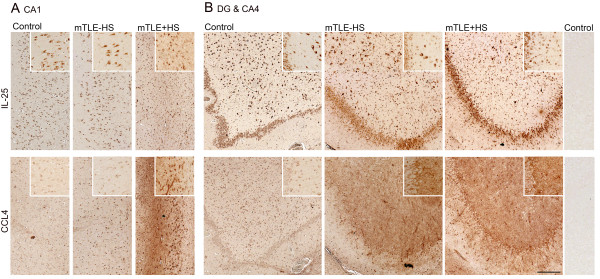
Hippocampal expression patterns of IL-25 and CCL4 in Control, mTLE-HS and mTLE + HS patients. Photomicrographs showing typical examples of Il-25 and CCL4 staining in the hippocampal CA1 region (A) and the DG/CA4 region (B). IL-25 immunoreactivity (IR) is evident in cells with neuronal morphology in all three patient groups (A, B); note the increased IL-25 staining in the mTLE + HS hippocampus in small cells. CCL4 IR is low in controls (A, B). Increased CCL4 IR is detected in both mTLE patient groups in the DG-CA4 area (B) and in the CA1 area of mTLE + HS patients (A). Scale bar = 200 μm.The insets are higher power magnifications taken from the same anatomical area